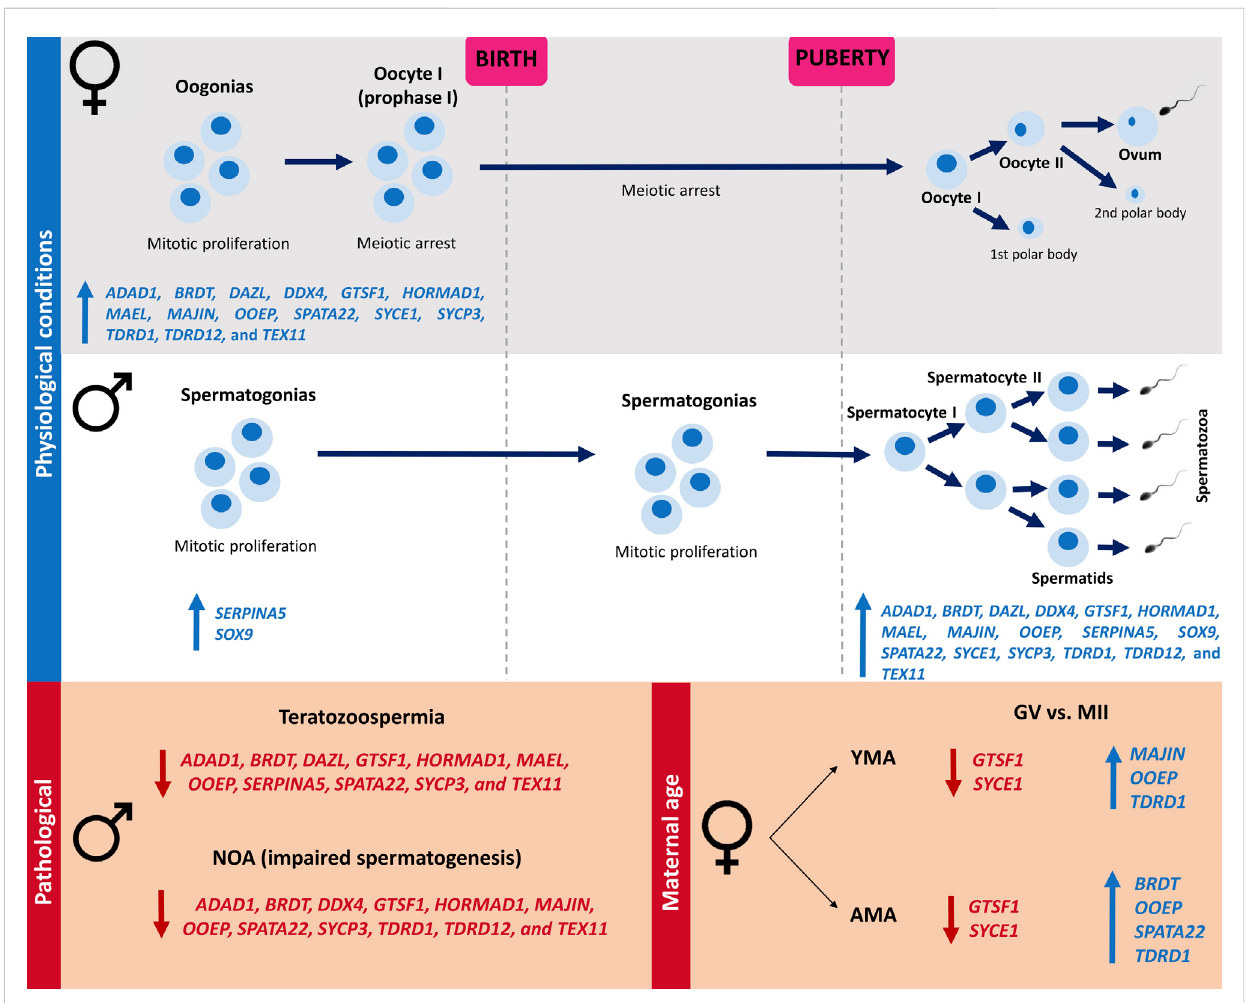
FIGURE 4 Illustration of the 17 meiosis-related genes expression in human ovary and testicle according to the life period and gametogenesis timing under physiological and pathological scenarios. Female meiosis initiates in fetal ovaries and is arrested in the prophase I stage before birth, being reestablished after puberty inperiodicalintervalsinresponseto hormonalstimuli. Inmales, thespermatogonialstem cellsremainquiescentduring theprenatalperiod,startingto proliferate and entering meiosis after puberty, resulting in continuous sperm production throughout the reproductive lifespan. It was demonstrated that duringadulthood,17meiosis-relatedgeneswereupregulatedinthetesticleincomparisontotheovary( ADAD1,BRDT,DAZL,DDX4,GTSF1,HORMAD1,MAEL , MAJIN, OOEP, SERPINA5, SOX9, SPATA22, SYCE1, SYCP3, TDRD1, TDRD12 , and TEX11) , whilst in all the prenatal periods analyzed, downregulation of these geneswas observed in the testicle in comparisonto the ovary, exceptby SERPINA5 and SOX9 , thatmaintain the upregulation in the testicle.It was observed a downregulation of ADAD1, BRDT, GTSF1, HORMAD1, OOEP, SPATA22, SYCP3 , and TEX11 in both teratozoospermic and NOA patients in comparison to the Control groups. A downregulation of DAZL , MAEL , and SERPINA5 was demonstrated only in teratozoospermic patients, as well as a downregulation of DDX4 , MAJIN , TDRD1 , and TDRD12 in NOA patients,in comparison to the Control groups.Comparing GV vs. MII oocytes, a downregulation of OOEP and TDRD1 , as wellasanupregulationof GTSF1 and SYCE1 ,wasobservedinMIIoocytesofbothAMAandYMApatients.Adownregulationof MAJIN inGVwasobservedonlyin YMA, and a downregulated of BRDT and SPATA22 in AMA. NOA (non-obstructive azoospermia); GV (germinal vesicle); MII (mature oocytes at metaphase II